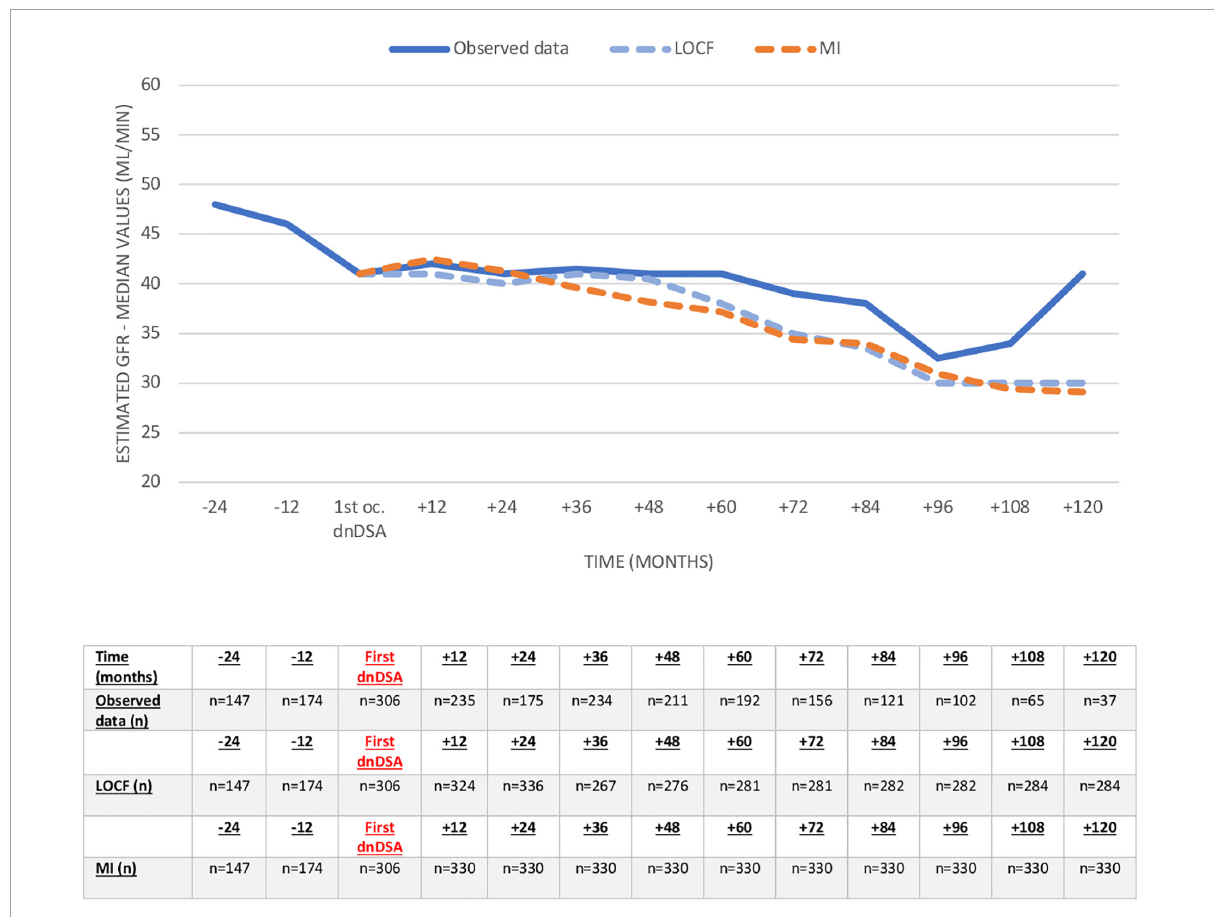
FIGURE5 Evolution of eGFR (ml/min) before and after the first occurrence of the first dnDSA. Missing values after dnDSA were imputed using last observation carried forward (LOCF) analysis and multiple imputation (MI). eGFR, estimated glomerular filtration rate; dnDSA, de novo donor-specific